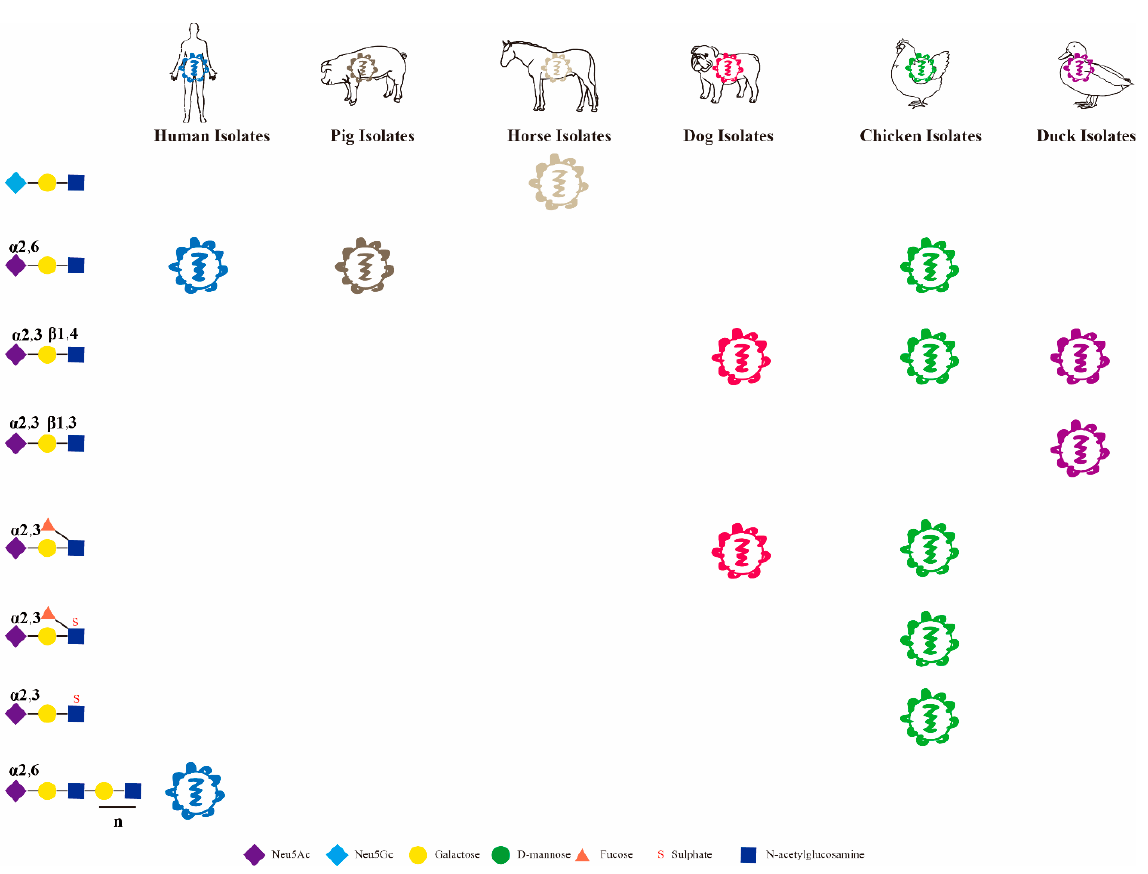
Figure 2. Preferential binding of influenza viruses of different host origins to sialic acids.